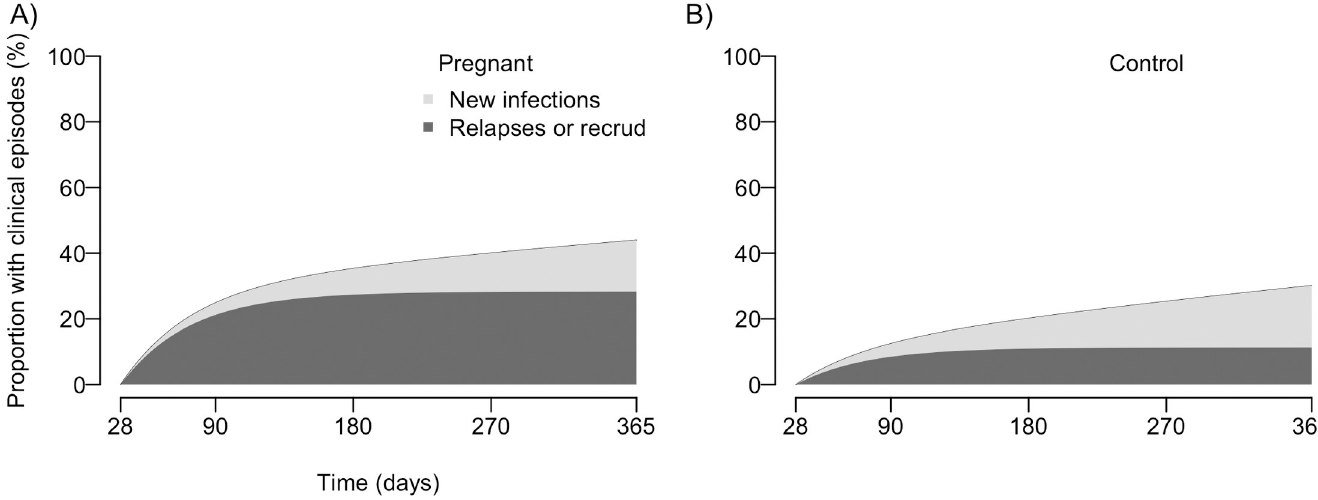
Fig 4. Cumulative distribution function of first vivax malaria recurrences among PQ-untreated pregnant women and PQ-treated non-pregnant controls. (A) First recurrence in pregnant women; (B) First recurrence in control women. The dark grey area in the graphs represents the proportion of subjects experiencing relapses/recrudescences and the light grey area represents the proportion of subjects experiencing new infections.